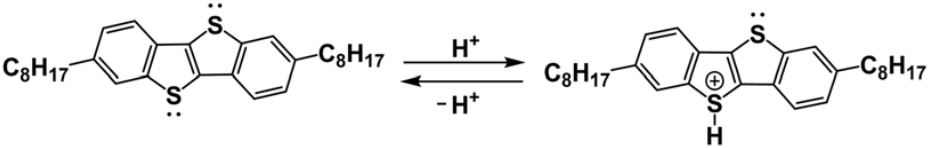
Figure 4. The scheme proposed for doping a C8-BTBT semiconductor with protons in water-based electrolyte solutions. electrolyte